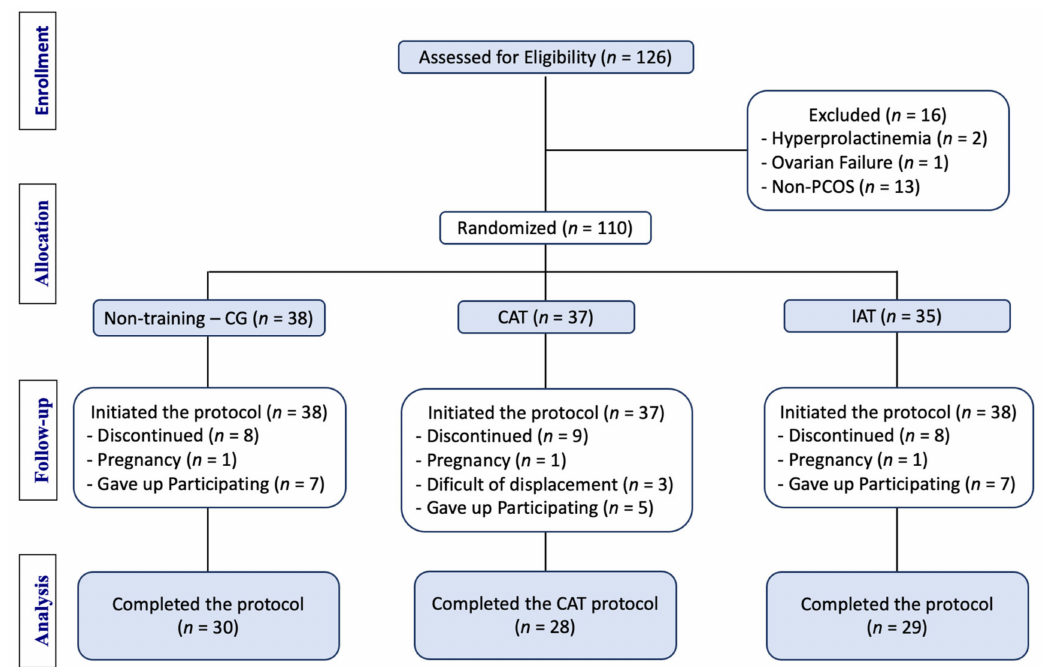
Figure 1. Flowchart of the